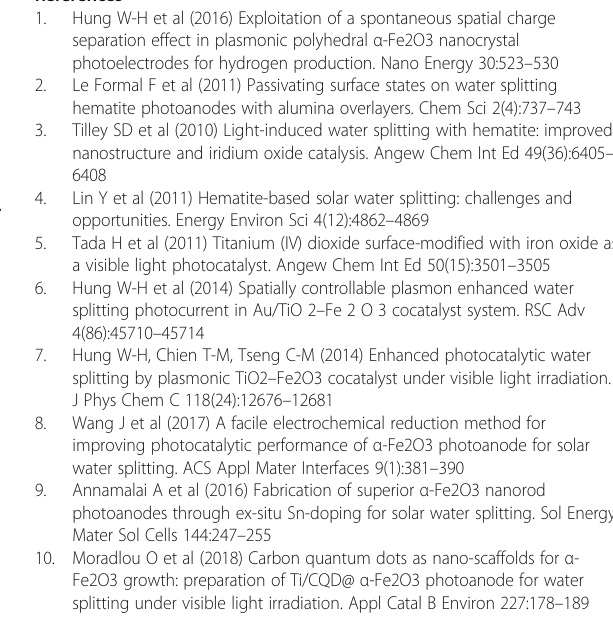
Additional file 1: Figure S1 . Mott-Schottky plot of the Zn/Sn doped PN photoelectrode of pseudocubic α -Fe 2 O 3 . Figure S2 . The comparison of XRD before/after